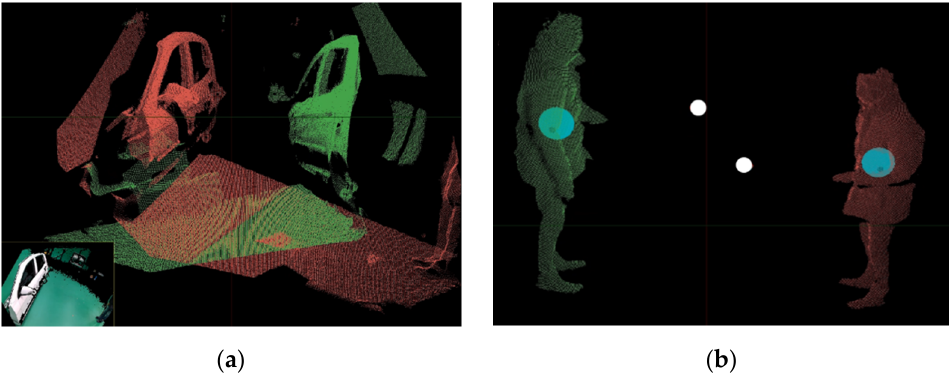
Figure 3. The 3D depth data visualization: ( a ) Captured from two Kinects (red points: left Kinect, green points: right Kinect; ( b ) Tracking of positions of a user and a capture tool in capture volume after background and noise removal (cyan circle: user position, white circle: capture tool position).